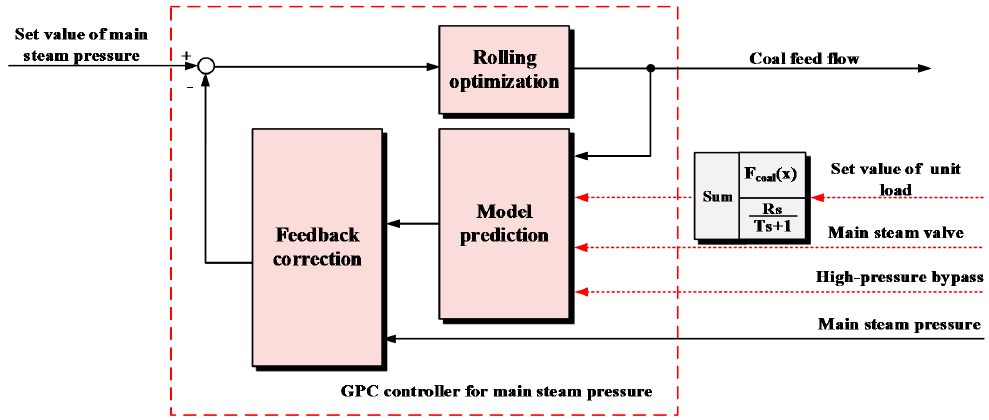
Figure 4. Control loop for main steam pressure.